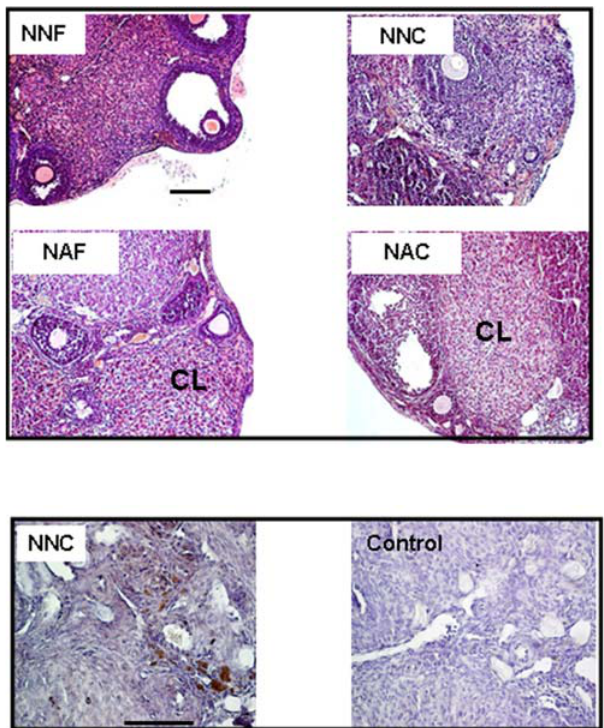
Figure 1. Histological analysis of ovary after one month of grafting and vascularization analysis. Immature ovarian cortex was grafted in non-pubertal mice freshly (NNF) either after cryopres- ervation (NNC) or in adult mice freshly (NAF) or after cryopreservation (NAC). Corpus luteum (CL) signs ovulation process. All images are at the same magnification. Representative slide of one ovary from NNC group is shown after immunohistochemical detection of vascularization using a -actin smooth muscle antibody as compared with control (without primary antibody). Scale bar, 100 m m